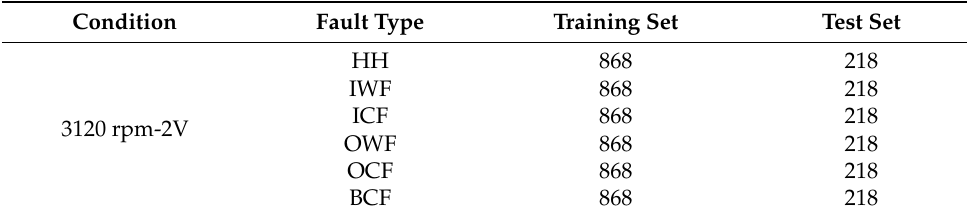
Table 5. Details of the mixed datasets.